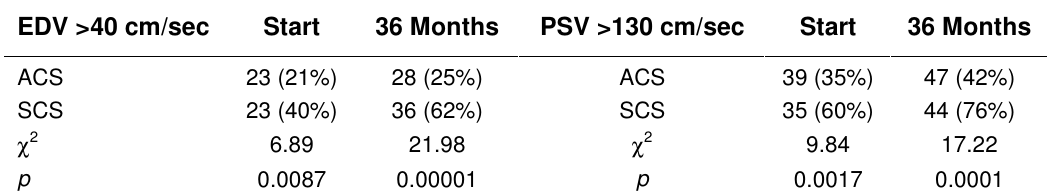
Frequency of Increased Maximal Peak Systolic and End Diastolic Velocities of Examined Carotid Stenoses at the Beginning and End of the Study EDV >40 cm/sec Start